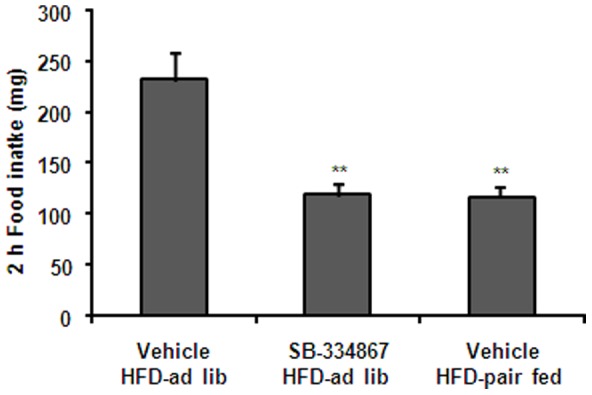
Orexin signaling blockade reduces spontaneous consumption of HFD.Figure shows 2-HFD-ad lib, SB334867-HFD-ad lib and vehicle-HFD-pair-fed groups. Values are the mean±SEM. **, p<0.01 vs. vehicle HDF-ad lib group.